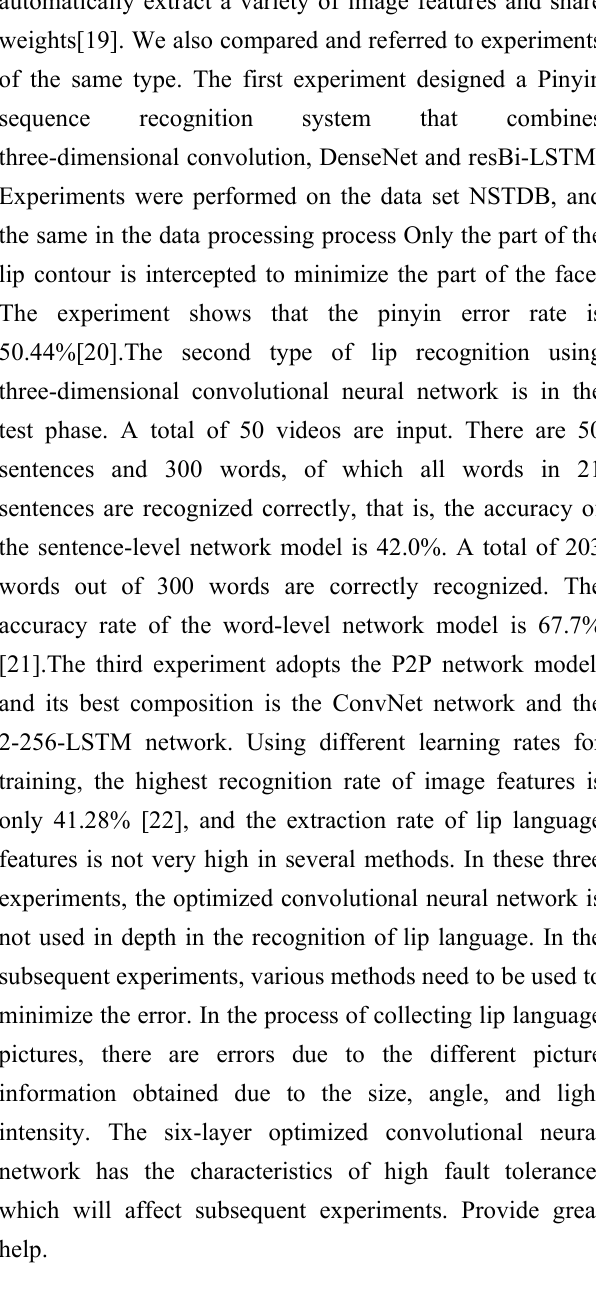
Table 5 Comparison of 3D+ DenseNet +1